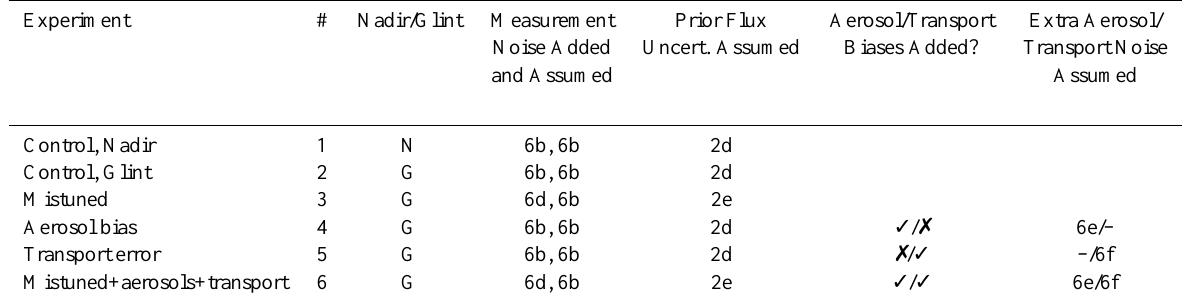
Table 1. The errors added to the true measurements and the random error sources assumed in the assimilation for the various OSSEs. Figure numbers are given for annual summary plots of the various added or assumed errors (e.g., “6b”). N=nadir, G=glint.